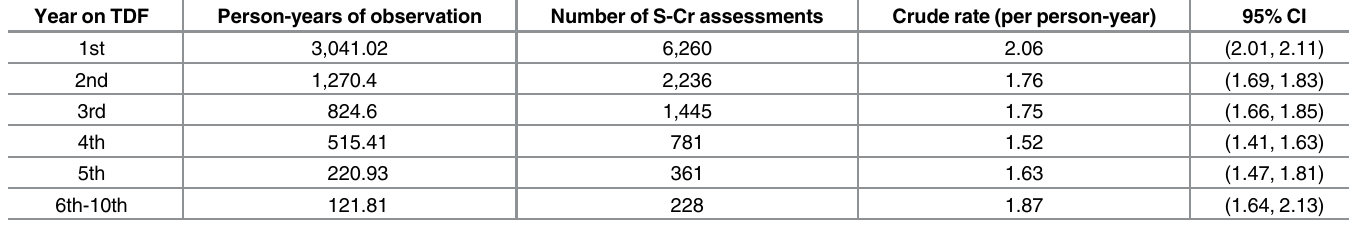
Table 3. Crude rates of serum creatinine monitoring for each year on